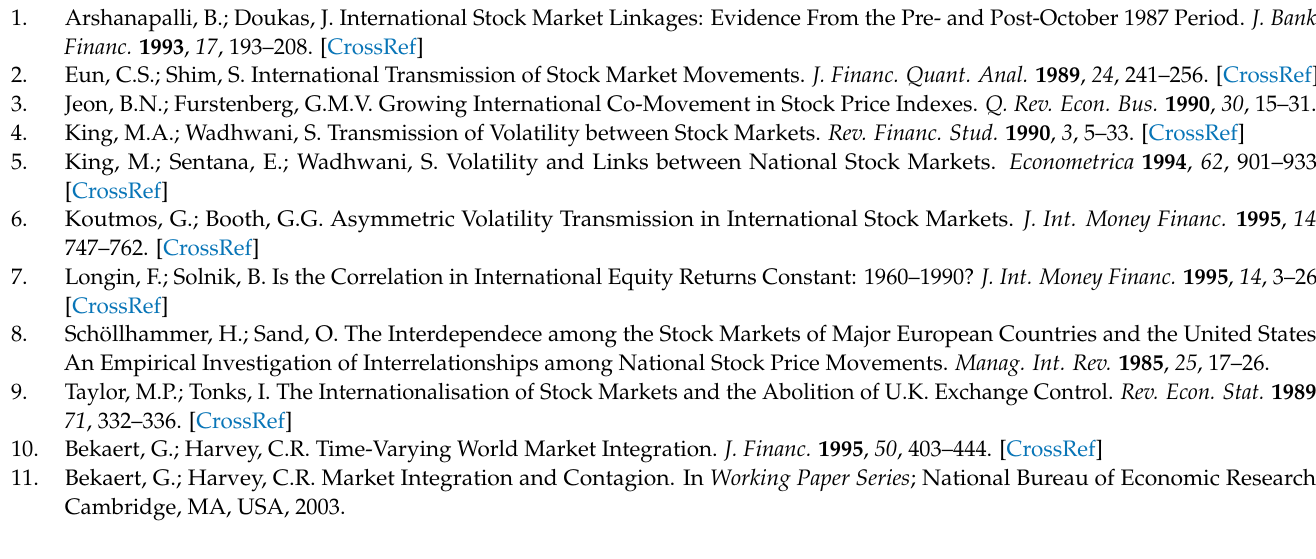
Table A4. Spillover Indexes of Energy and Emerging Markets based on Different Forecast Windows. From SpilloverEnergy